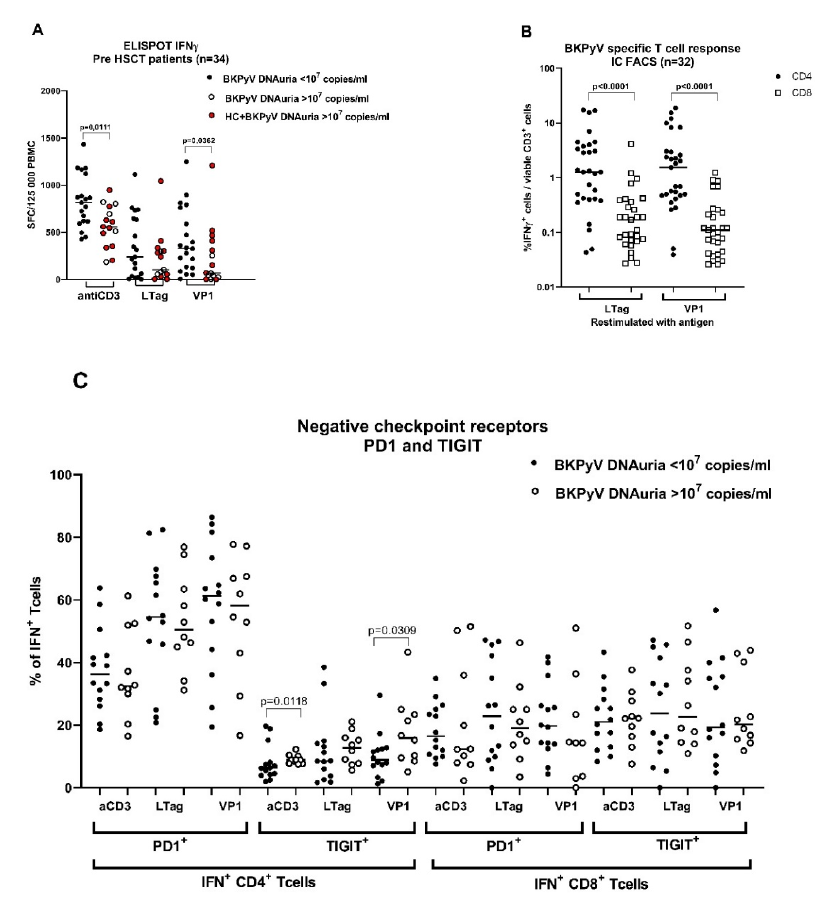
Figure 3. Pretransplant non-specific and BKPyV specific T-cell response in HSCT patients in PBIHC study. ( A ) The response to stimulation with anti-CD3 and BKPyV antigens LTag and VP1 was determined in a subgroup of BKPyV-infected patients by ELISPOT-IFN γ ( n = 34). Patients were stratified according to the maximal BKPyV DNAuria levels detected during the first year after HSCT. The red circles stand for samples from patients with HC. ( B ) The results of ELISPOT-IFNγ were confirmed by the IC FACS-IFNγ in those patients with sufficient yields of expanded T-cells ( n = 32). ( C ) The presence of negative checkpoint receptors PD1 and TIGIT was determined by FACS in IFNγ producing T-cells. Analysis was performed using the gating strategy shown in Figure 1. Statistical analysis was performed using the Mann–Whitney test ( A , C ) or the Wilcoxon matched-pairs signed rank test ( B ).